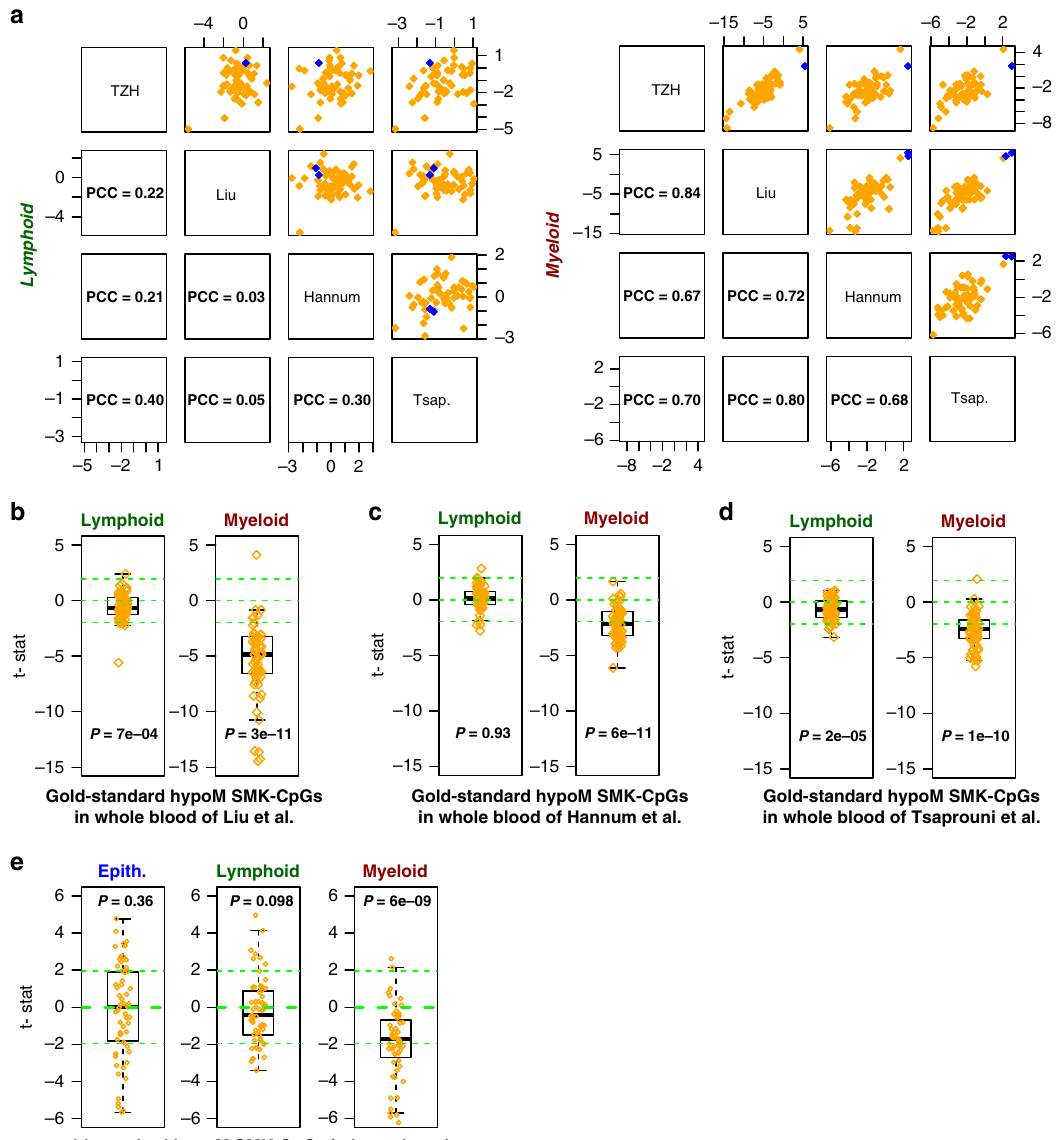
Fig. 2 Cell-type speci fi c smoking-associated DNAm patterns of gold-standard smoking CpGs in independent cohorts. a Scatterplots of cell-type speci fi c t -statistics (as obtained with CellDMC) across four whole blood cohorts (TZH, Liu, Hannum, and Tsaprouni) with associated Pearson Correlation Coef fi cient (PCC) values, and separately for the lymphoid (left) and myeloid (right) lineages. The t -statistics are displayed for the 62 gold-standard smoking-associated CpGs (60 hypomethylated (orange) and 2 hypermethylated (blue)). b Boxplots of t -statistics of association of DNAm with smoking in the whole blood ( n = 689) from Liu et al., as derived with CellDMC for both lymphoid and myeloid lineages. Boxplots only display the 60 gold-standard smoking hypomethylated CpGs from Gao and Brenner. P value derives from a one-tailed Wilcoxon rank sum test. Horizontal line within boxes indicate median, box-boundaries the interquartile range, and whiskers extend to 1.5 times this range. c – e As b , but now for the 656 samples from Hannum et al., the 464 samples from Tsaprouni et al., and the 790 buccal swab